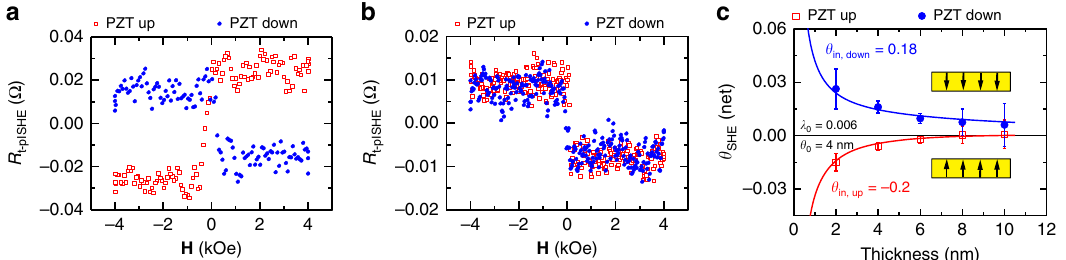
Fig. 3 Pt-thickness-dependent t-pISHE response at the two ferroelectric polarization states of PZT. a , b t-pISHE response in 6 nm and 8 nm Pt (Devices B series) at two PZT polarization states of pointing up (red empty squares) and down (blue solid circles), respectively. c net spin Hall angle ð θ ð net Þ ¼ V t (cid:2) pISHE σ Þ as a function of Pt thickness (Devices C series). The red (blue) solid lines through the data points are fi ts to θ SHE J e P LSMO L based on two PZT polarization states. The respective spin Hall angles extracted from the fi ts are denoted. Fitting parameters: θ 0 = 0.006, λ in = 0.2 nm , λ = 4 nm. The error bars represent the standard deviation obtained from three different 0